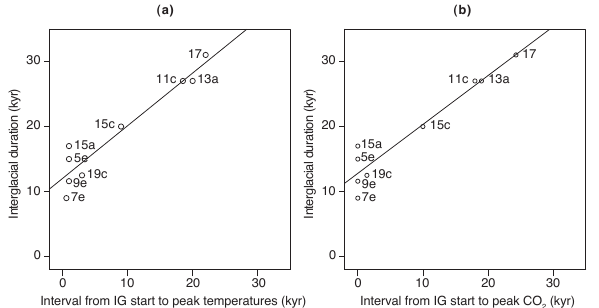
Fig. 9. Plot of the interval of time over which peak interglacial values are attained versus duration. (a) interval of time from inter- glacial start to peak GL T − syn temperatures versus interglacial du- ration; (b) interval of time from interglacial start to peak CO 2 con- centrations versus interglacial duration. The regression lines ( R 2 0.91) are essentially shifted from the 1:1 line by ∼ 10kyr, repre- senting an interglacial “relaxation” time back to glacial conditions.